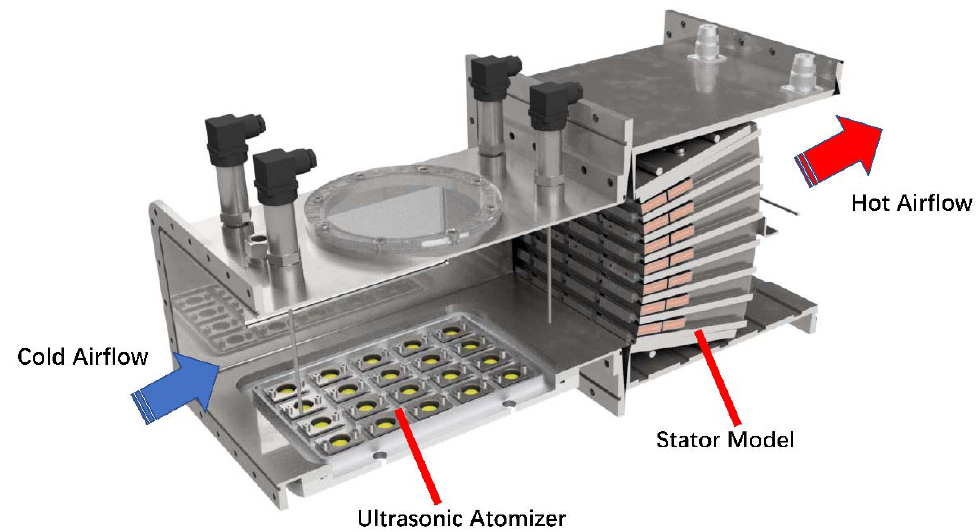
Figure 3. The rendering of the mixer and stator model.